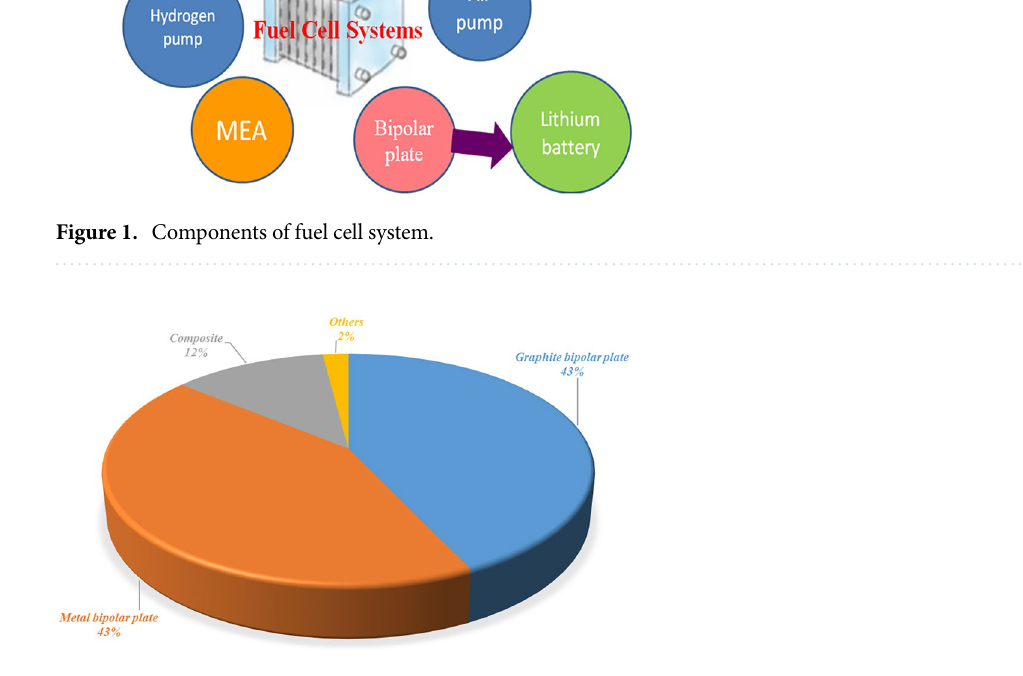
Figure 2. Patent applications for inventions on proportional bipolar